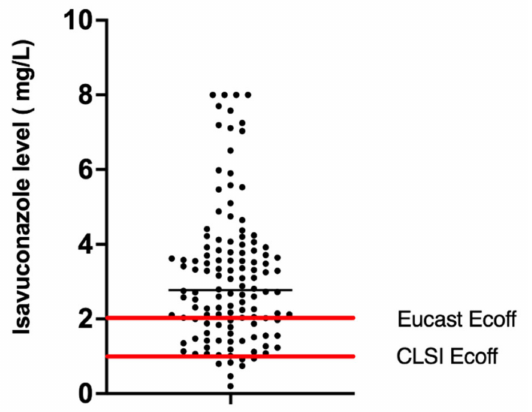
Figure 4. Scatter plot of distribution of isavuconazole drug concentrations. The median level is indicated by the horizontal black line, with horizontal red lines indicating the EUCAST and CLSI ECOFF for Aspergillus fumigatus ( n = 132 isavuconazole drug level measurements